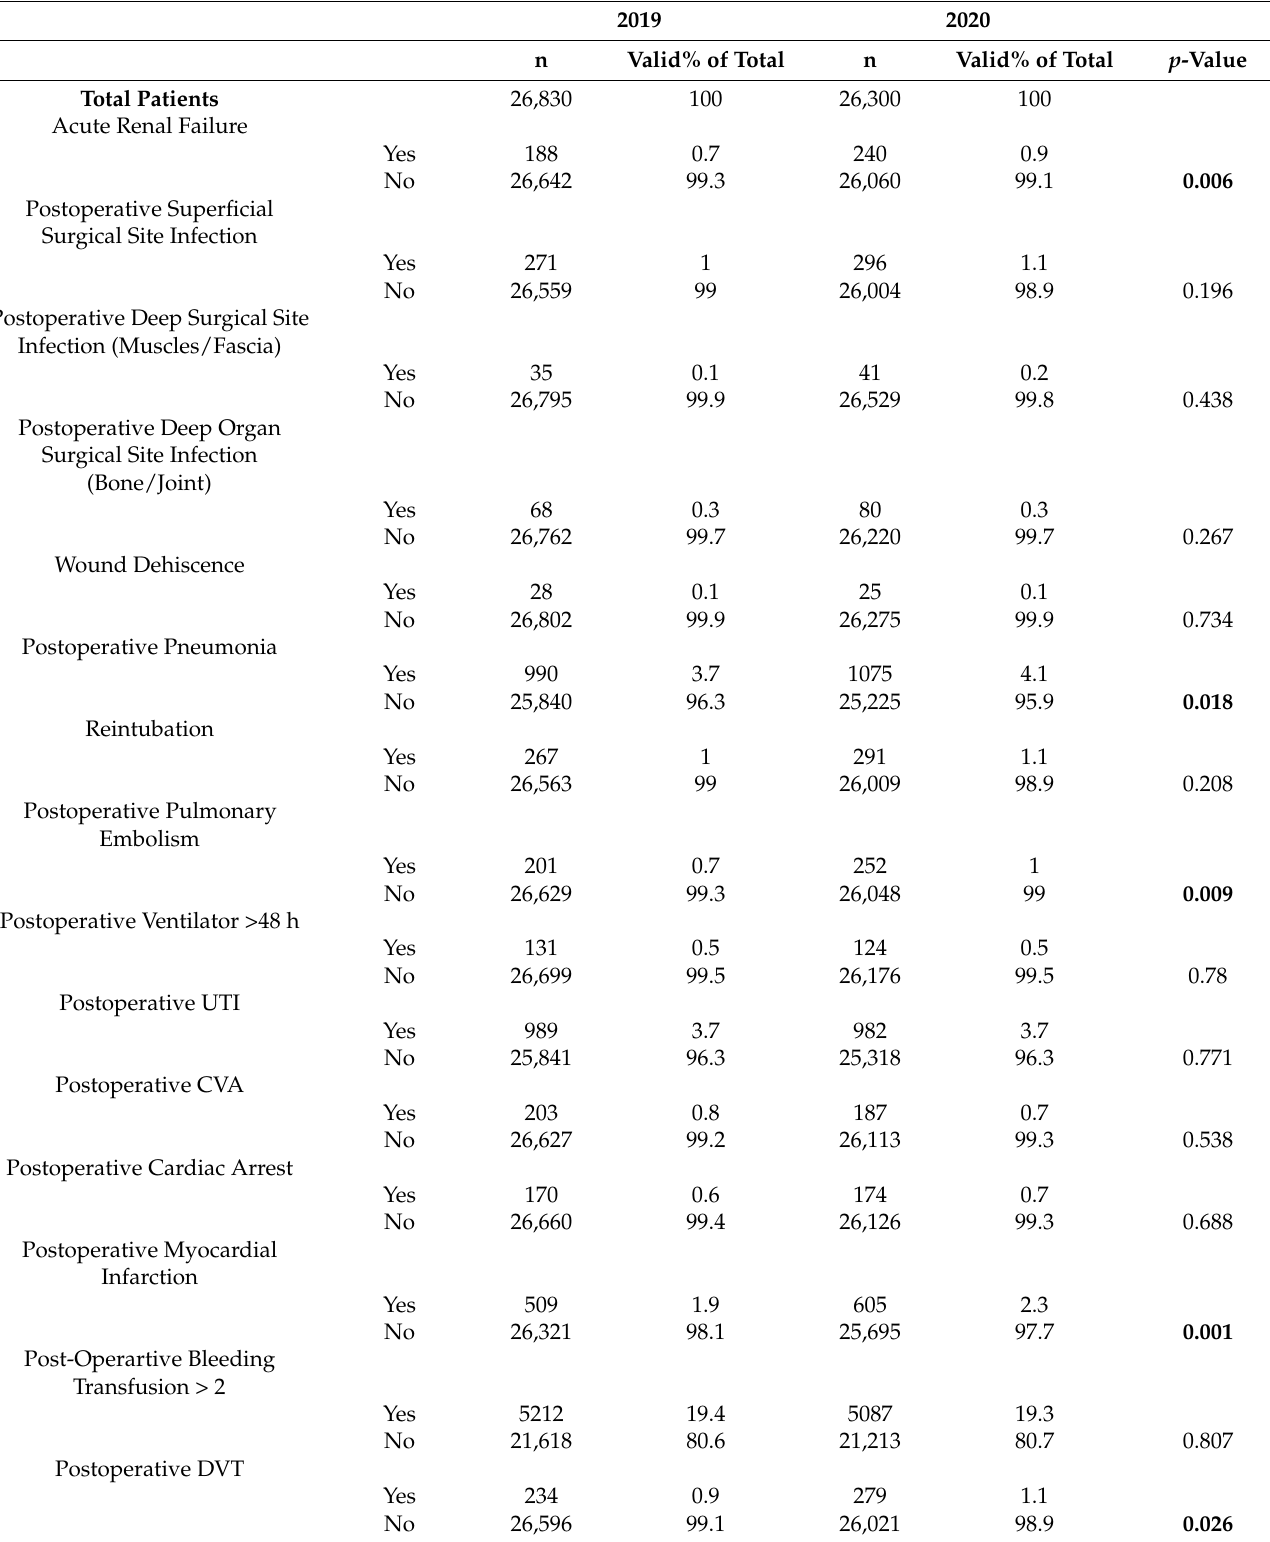
Table 2. Cross Table Year of Diagnosis and Postoperative Patient Characteristics with Traumatic Proximal Femoral